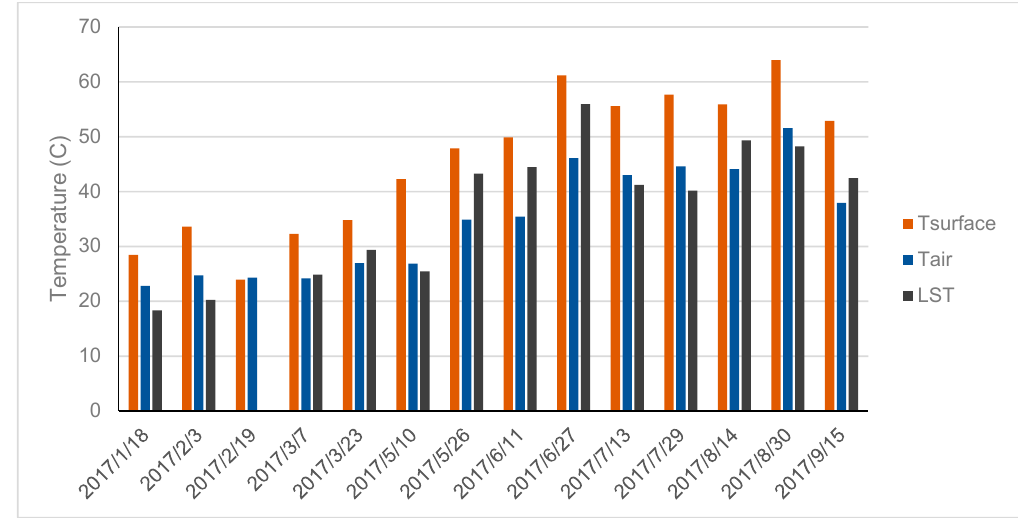
Figure 6. Comparison of the T surface , T air , and LST at the hour of the Landsat fly-over for a selected measurement location (13).